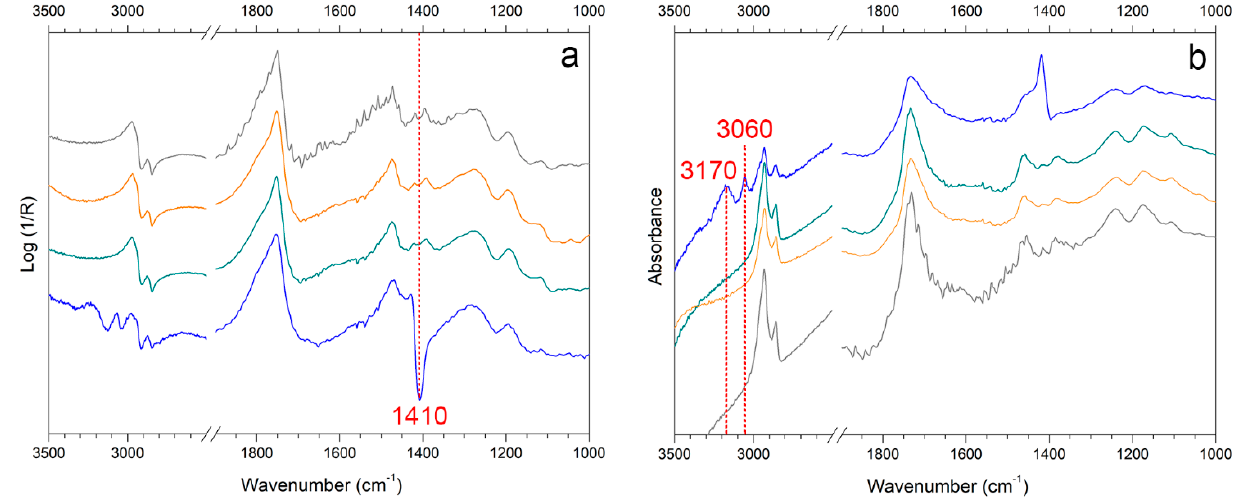
Figure 10. Reflection FTIR spectra in ( a ) pseudo-absorbance and ( b ) after Kramers-Kronig transform of WM (gray) and sweat-WM (blue) cleaned with SA_3 (green) and KG_3 (orange). The marker bands selected for identifying soiling mixture and synthetic sweat components are reported.